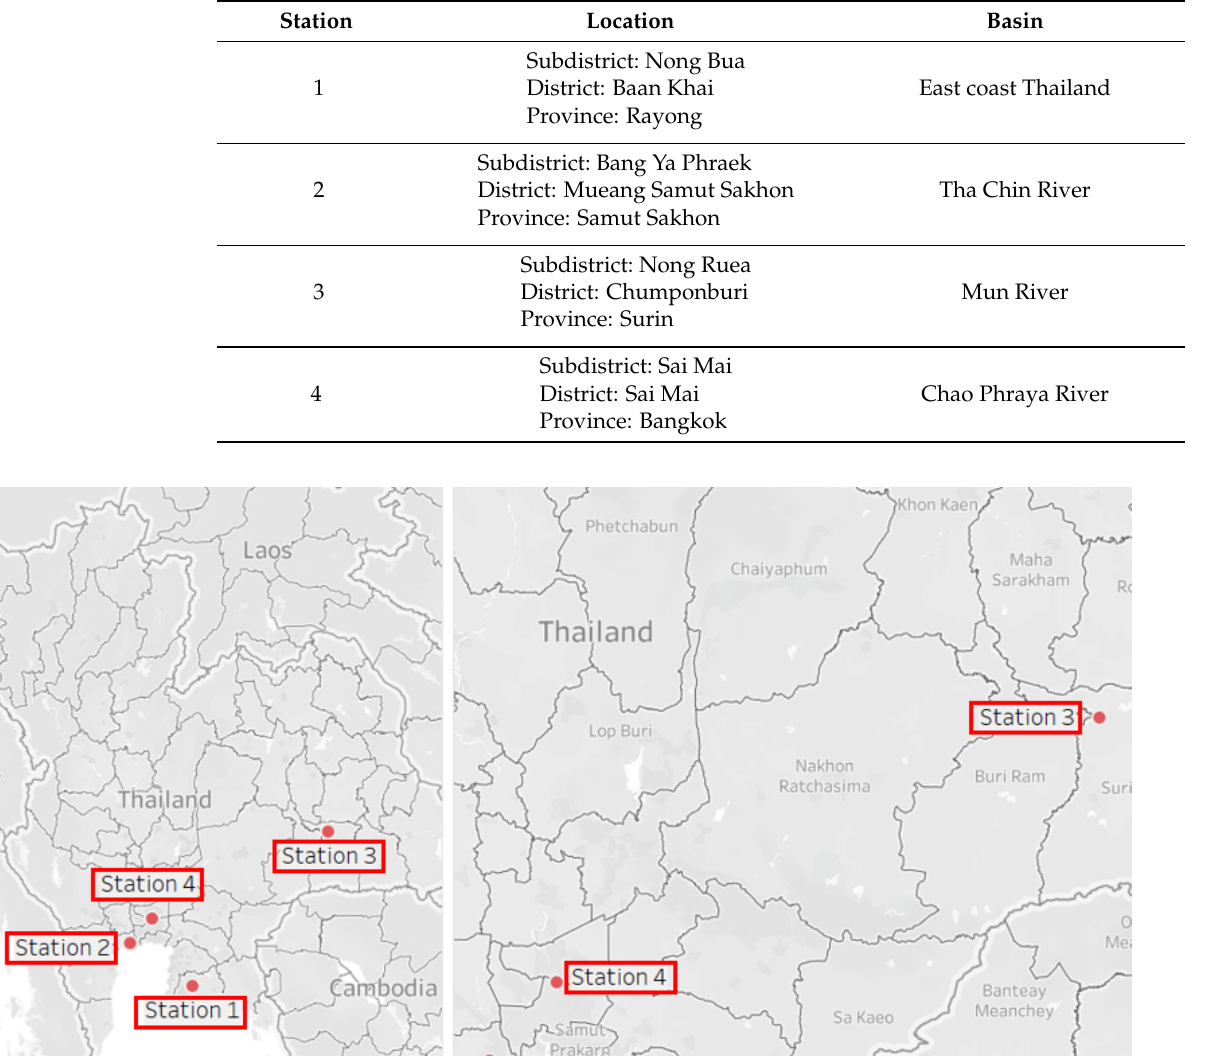
Table 1. Descriptions of the selected stations.